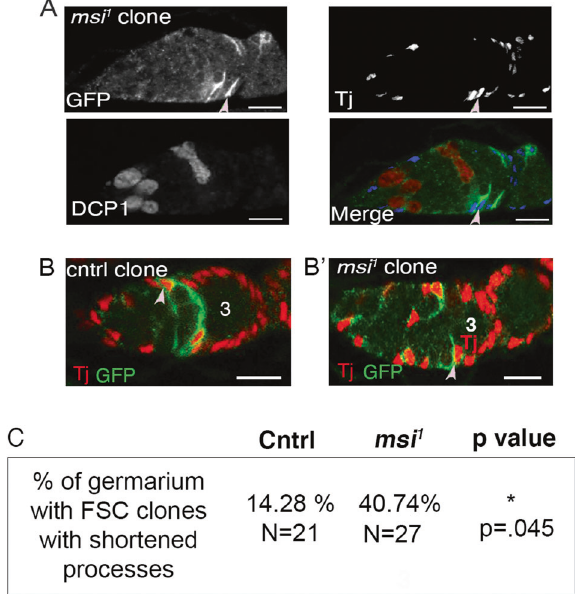
Fig. 4 msi mutant FSC clones do not express Dcp-1 but display aberrant morphology. A Single-plane confocal micrographs show- ing Tj-positive (blue in merged panel) and GFP-positive MARCM msi null FSC clone (green in last panel). This image depicts Dcp-1 positive germ cells dying as a control for Dcp-1 antibody labelling. B Single-plane confocal micrograph showing a control, layer 1 GFP- positive FSC clone (light pink arrowhead) with an axon-like projection extending across the germarium. B ’ Single-plane confocal micrograph showing a msi null, layer 1 GFP-positive FSC clone (light pink arrowhead) with a shortened, aberrant projection. C Table represents the % of control ( N = 21) and msi 1 ( N = 27) mutant 10 day old FSC MARCM clones with shortened axon-like processes. p value (0.045) was calculated using Fisher ’ s exact test. Ovarioles were acquired from a minimum of 15 heat shocked females for each genotype. Scale bars, 10 µm. Three represents a region 3/stage 1 egg